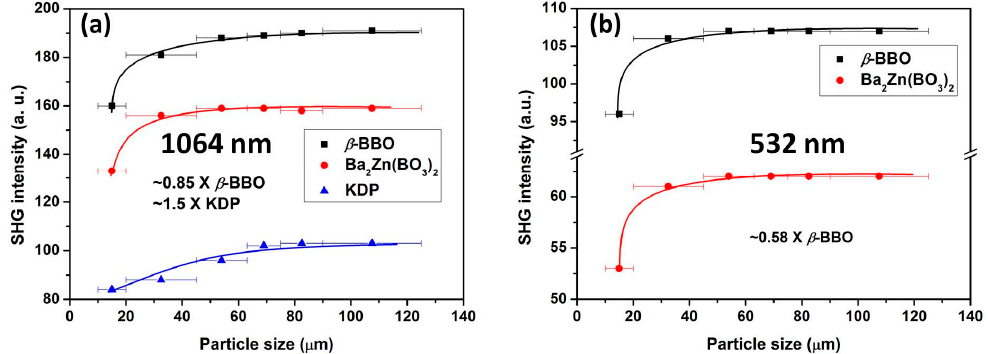
Figure 5. Powder SHG measurement of polycrystalline Ba 2 Zn(BO 3 ) 2 at the fundamental wavelengths of ( a ) 1064 nm ( b ) 532 nm. Note the curves are drawn to guide the eye and are not a fit to the data.